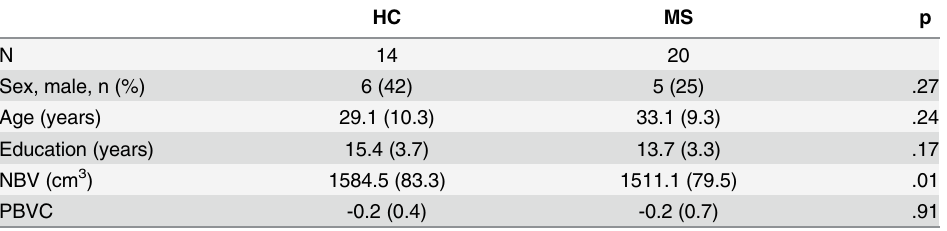
Table 1. Demographics and morphological MRI characteristics of healthy controls (HC) and patients with multiple sclerosis (MS).